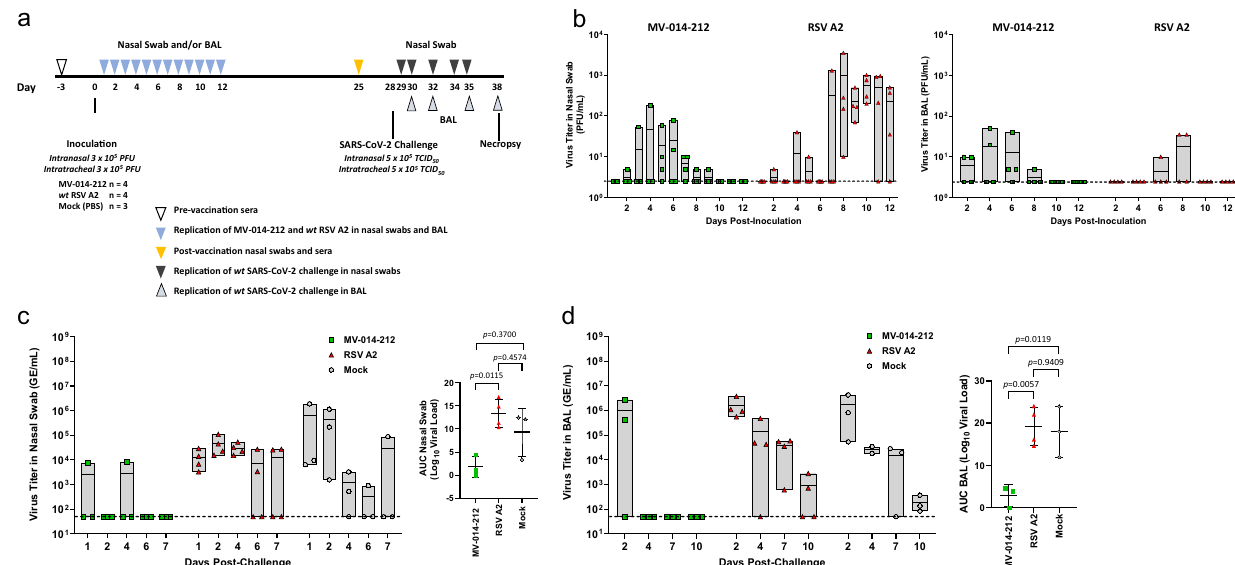
Fig. 3 MV-014-212 attenuation in African green monkeys (AGMs) and protection against SARS-CoV-2 challenge. a AGM study design. Nasal swabs (NS) were obtained on days 1 through 12 after vaccination. Bronchoalveolar lavages (BALs) were collected on days 2, 4, 6, 8, 10, and 12. Viral shedding of the vaccine or control virus in NS and BAL samples was determined by plaque assay using fresh samples. On day 28 post-inoculation, AGMs were challenged with wild type ( wt ) SARS-CoV-2. Nasal swabs were obtained on days 1, 2, 4, 6, and 7 post challenge. BAL was obtained on days 2, 4, 7, and 10 post challenge. b Attenuation of MV-014-212 in the upper and lower respiratory tract of AGM. Viral titer in NS (left) or BAL (right) from AGMs following inoculation with MV-014-212 or wt respiratory syncytial virus (RSV) A2 were measured by plaque assay on Vero cells. Each data point is the mean of 2 technical replicates. The box represents the range of the data and the horizontal line is the mean value for each time point. The dotted line represents the limit of detection (50 PFU/mL). N = 4 AGMs for each group. For shedding kinetics of individual animals see Supplementary Fig. 7. Protection of MV-014-212-vaccinated AGMs against wt SARS-CoV-2 challenge in nasal swabs ( c ) and BAL ( d ). SARS-CoV-2 sgRNA levels were measured by RT-qPCR and expressed as genome equivalents (GE)/mL. The horizontal line in the box is the mean of all measurements at each time point. The dashed line represents the limit of detection of 50 GE/ mL. Each data point corresponds to one animal ( N = 3 AGMs for MV-014-212 and mock groups and N = 4 AGMs for RSV A2 group). For shedding kinetics of individual animals see Supplementary Fig. 9. Statistical analysis was one-way ANOVA with Tukey ’ s multiple comparisons. P -values are shown. Bars are mean and error bars denote